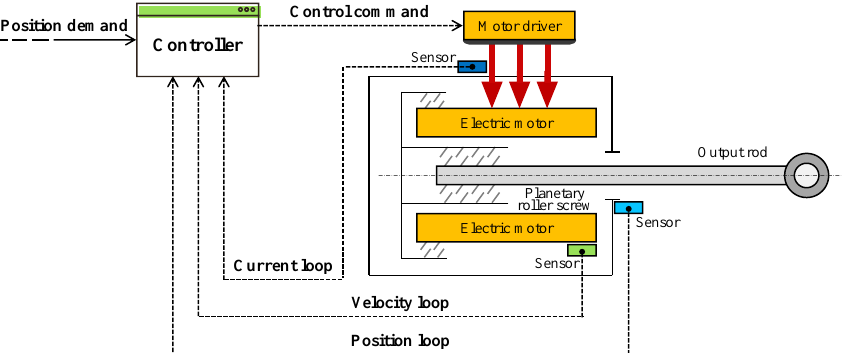
Figure 1. EMA schematic diagram.